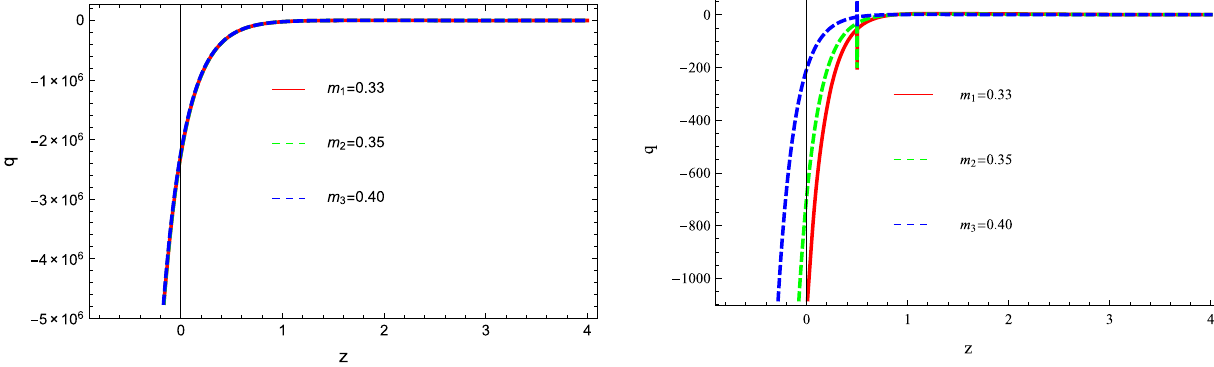
Fig. 18 Plots of intermediate deceleration parameter q for u = 2 (left) and − 2 (right). Also, H 2 = 2 . 7 (red), H 2 = 2 . 75 (green) and H 2 = 2 . 8